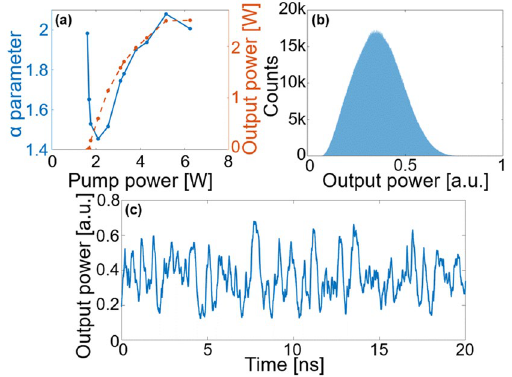
Figure 2. ( a ) Lévy α parameter fitted from experimental data (solid blue) and laser output power (dashed orange), as a function of input pump power. ( b ) Histogram of the output power at 5.6 W pump power, sampled over 10 million points. ( c ) Sample time sequence of the output power, at 5.6 W pump